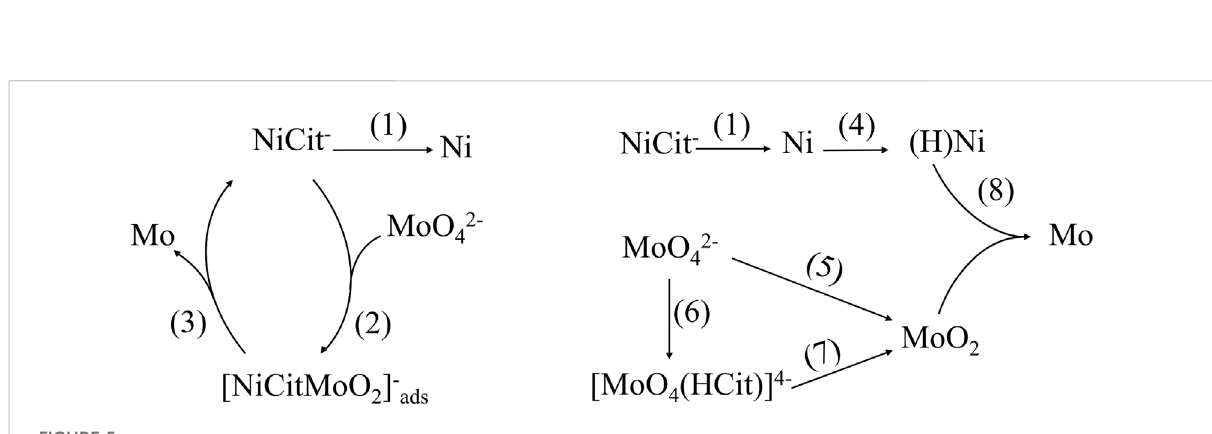
FIGURE 5 Two possible mechanisms of Ni – Mo